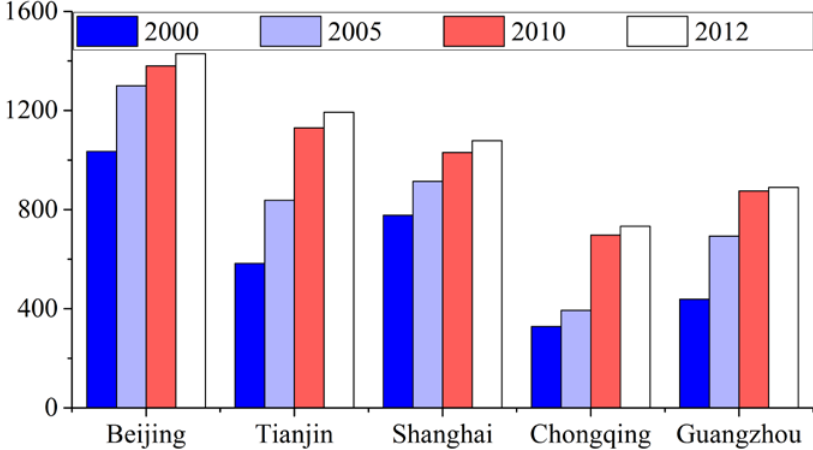
Figure 4. Urban areas of five Chinese megacities (km 2 ), 2000–2012.